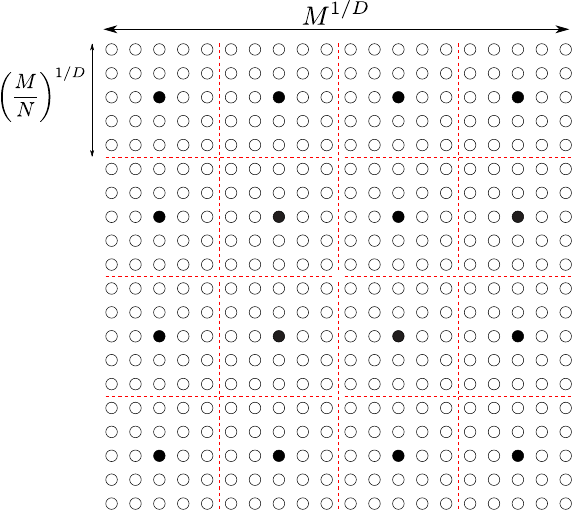
FIG. 6. A depiction of the initial state in Ref. [10]. Empty circles represent empty lattice sites, and filled circles represent initially occupied